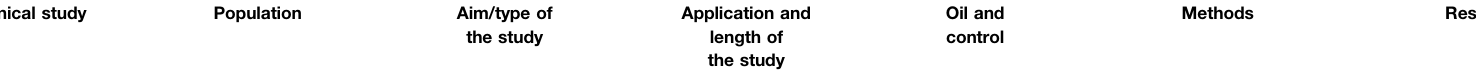
TABLE 4 | ( Continued ) Clinical studies evaluating the dermal effects of vegetable butters and oils. AD — atopic dermatitis, GC — gas chromatography, MC — molluscum contagiosum , SA — Staphylococcus aureus , SC — stratum corneum, SG — striae gravidarum, SLS — sodium lauryl